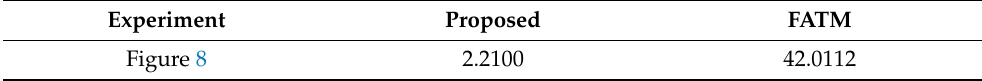
Table 5. Average position errors (in pixels) of the entire Figure 8 experiment. Experiment Proposed Figure 8